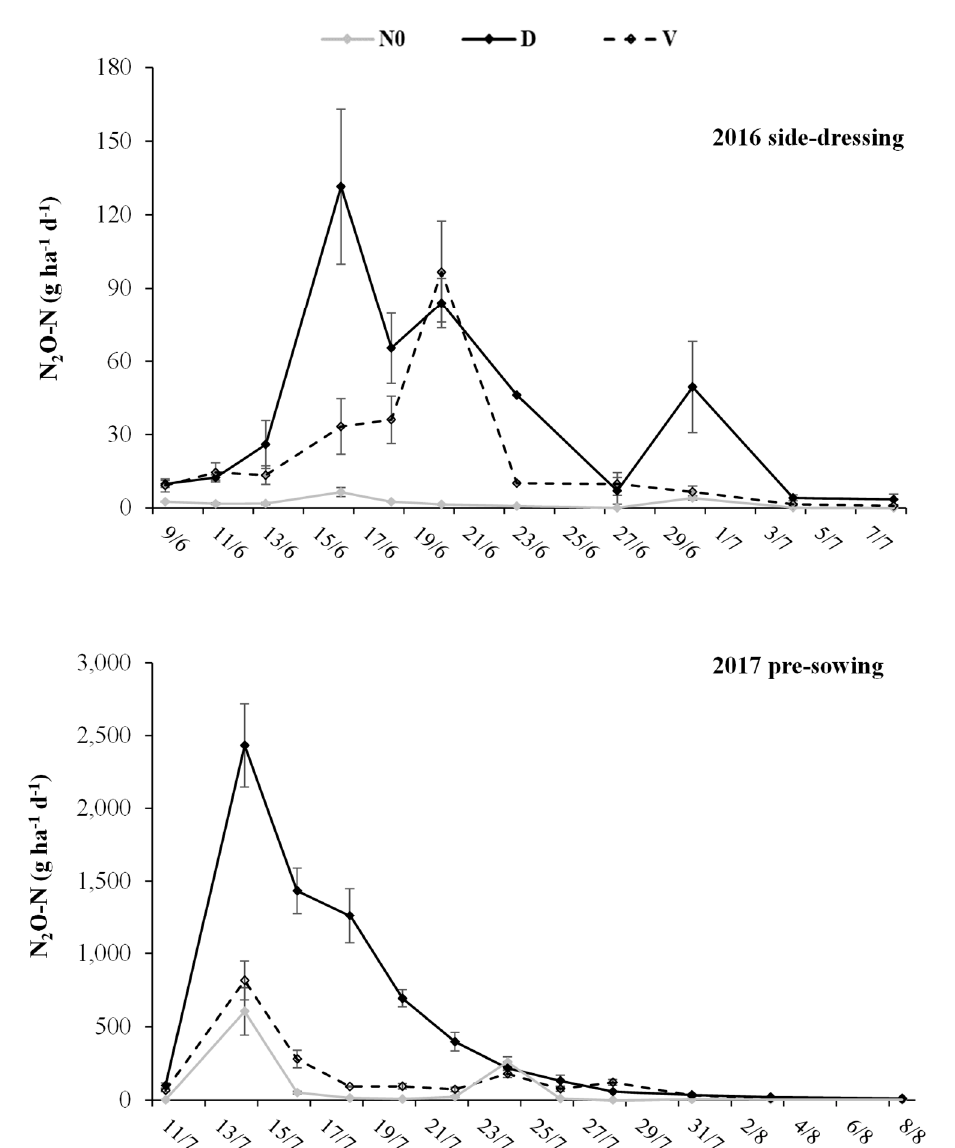
Figure 2. Mean daily N 2 O emissions (g N 2 O-N ha − 1 d − 1 ) after side-dressing (“2016”, upper panel) and pre-sowing (“2017”, lower panel). Non-fertilized plot (N0), digestate injection (D) and digestate + DMPP injection (V). The displayed data were calculated as mean across blocks ( n = 3). Error bars represent mean standard error, ±.